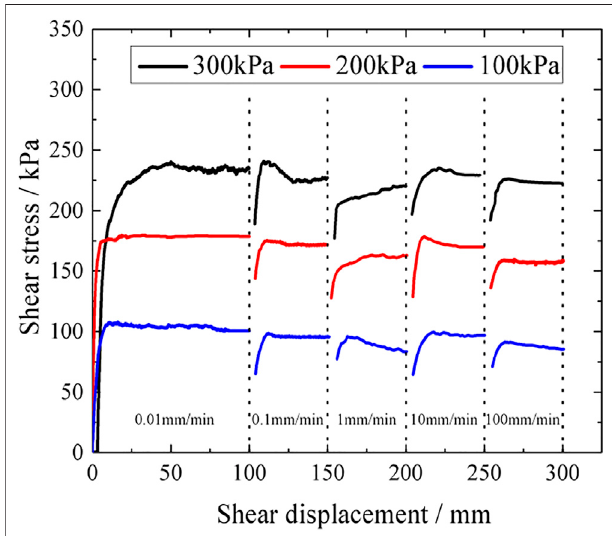
FIGURE 10 | The relationship curve of shear stress-shear displacement of specimen under different shear